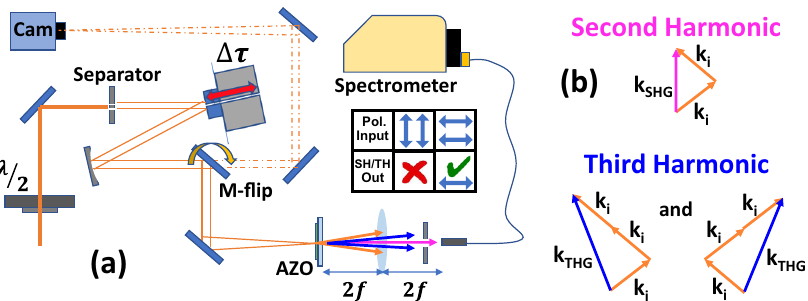
Fig. 1 Zero-Index FROG. a Experimental setup used to record FROG traces. Central panel summarises input/outputpolarisation states. Maximum frequency conversion was attained for horizontally polarised input beams for both SH and TH (both horizontally polarised). No harmonic generation can be found for a vertically polarised input. b Breakdown of phase matching conditions for each harmonic generated in the fi lm.